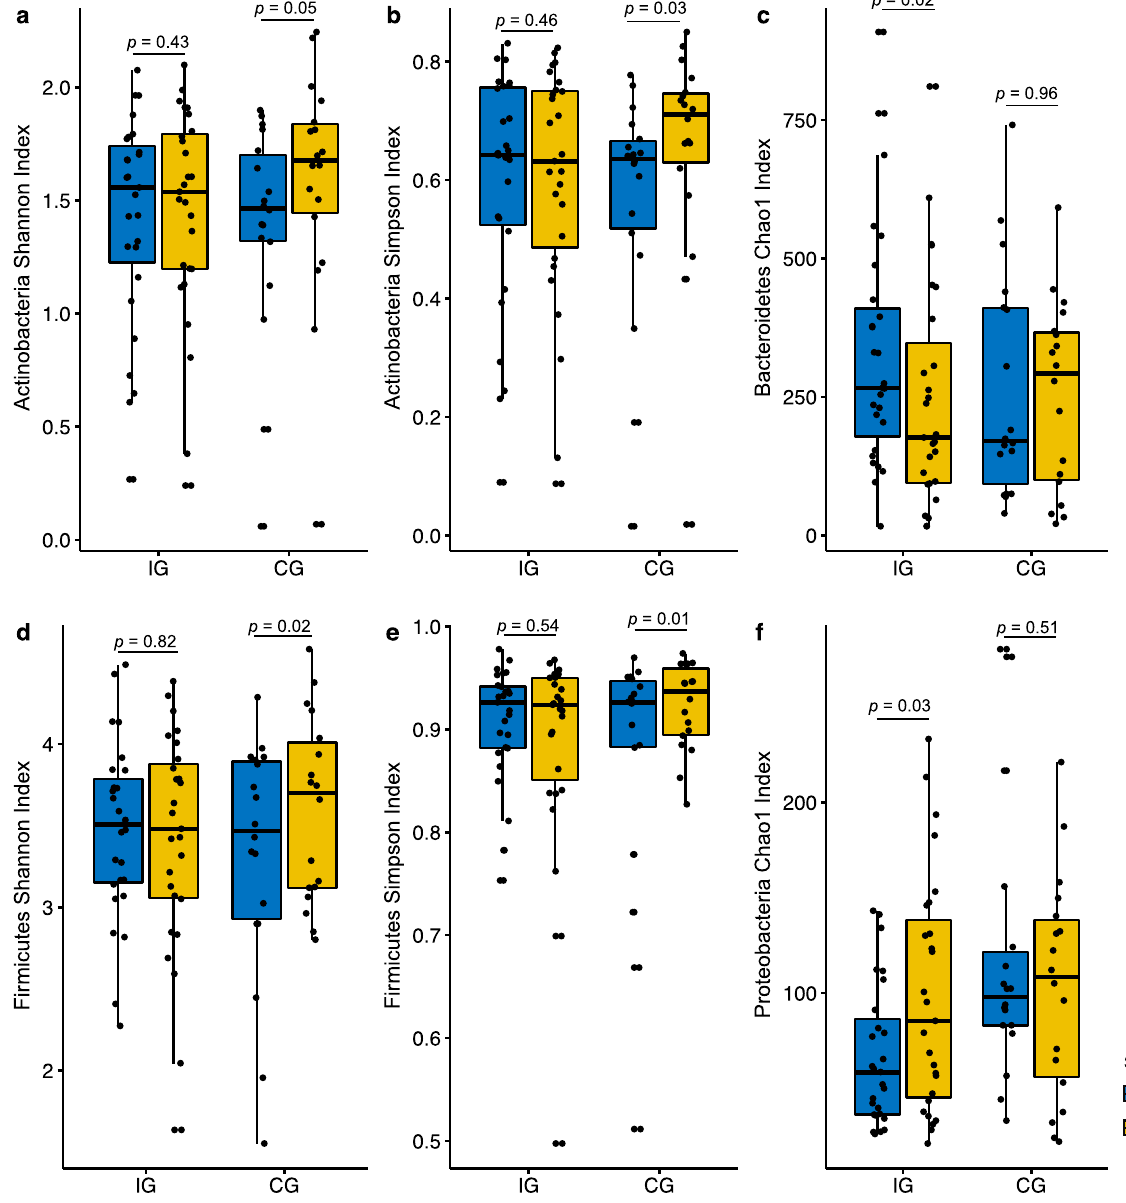
Figure 3. Alpha diversity changes between pre- and post-intervention in IG (n = 27) and CG (n = 18). ( a ) Shannon index of Actinobacteria. ( b ) Simpson index of Actinobacteria. ( c ) Chao1 index of Bacteroidetes. ( d ) Shannon index of Firmicutes. ( e ) Simpson index of Firmicutes. ( f ) Chao1 index of Proteobacteria. Blue colour indicated pre-samples, yellow colour indicated